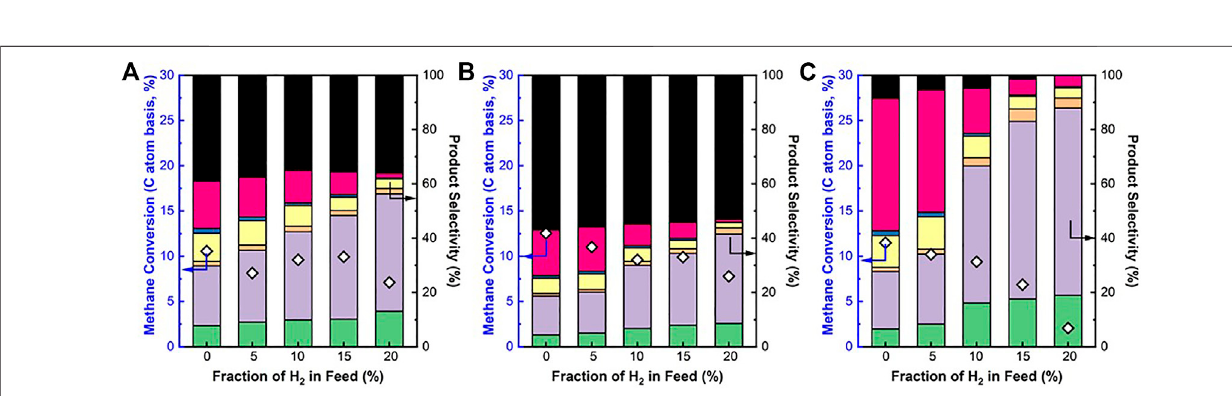
Frontiers in Chemistry |